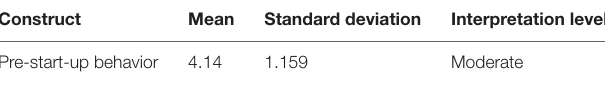
TABLE 4 | Mean and standard deviation of pre-start-up